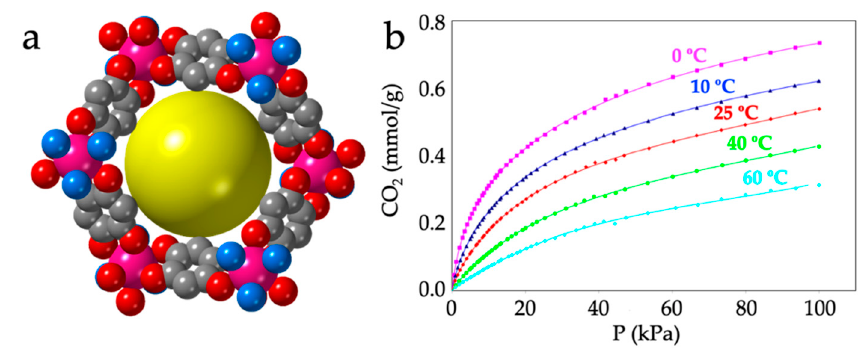
Figure 25. ( a ) View of an empty hexagonal cavity in compounds 35 ‐ 49 . ( b ) Adsorption isothermal for CO 2 uptake at different temperatures for compound 43 .